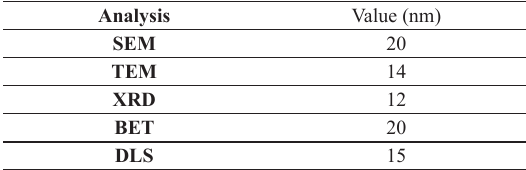
Table 1. Result of particle size by different techniques.